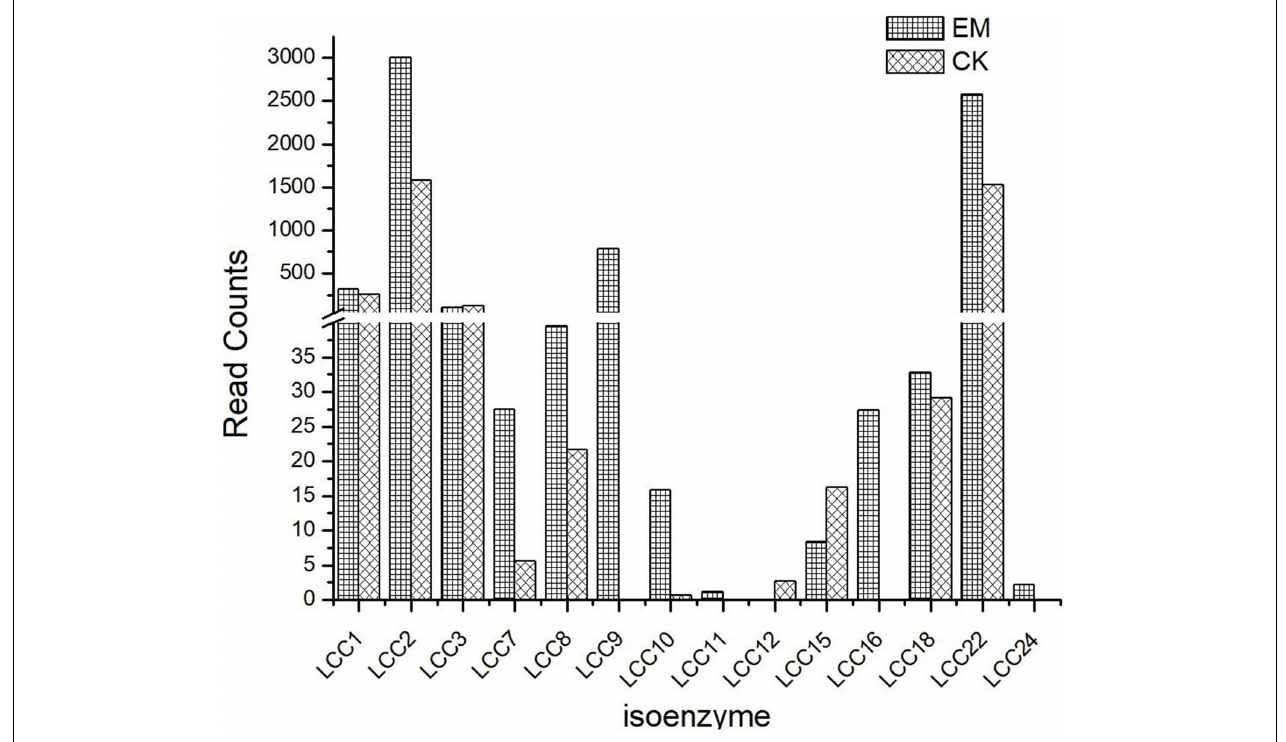
FIGURE 2 | Laccase isoenzyme expression in two groups of